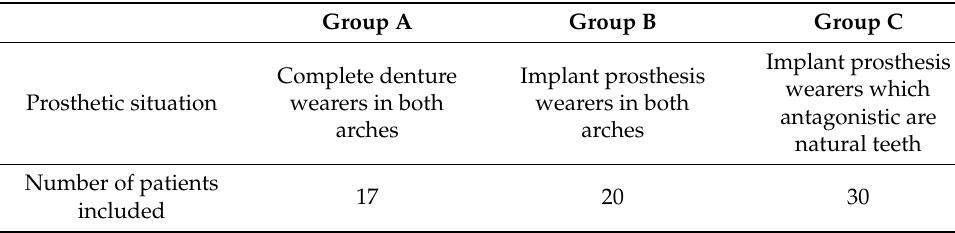
Table 1. Sample size.